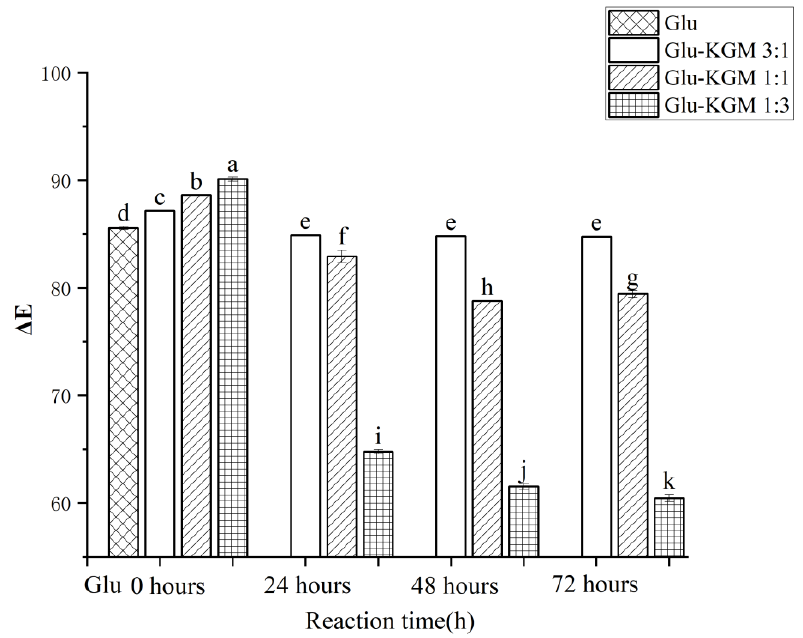
Figure 2. Total color changes of gluten, mixtures, and conjugates, respectively. The results with different letters were significantly different ( p < 0.05).